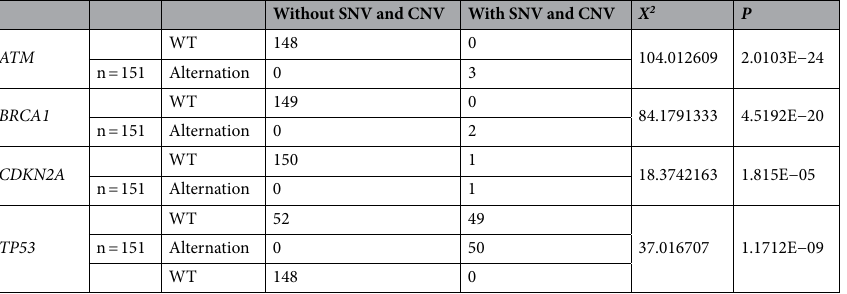
Table 1. Relationship between changes in m5C regulatory genes and high-frequency PAAD-related